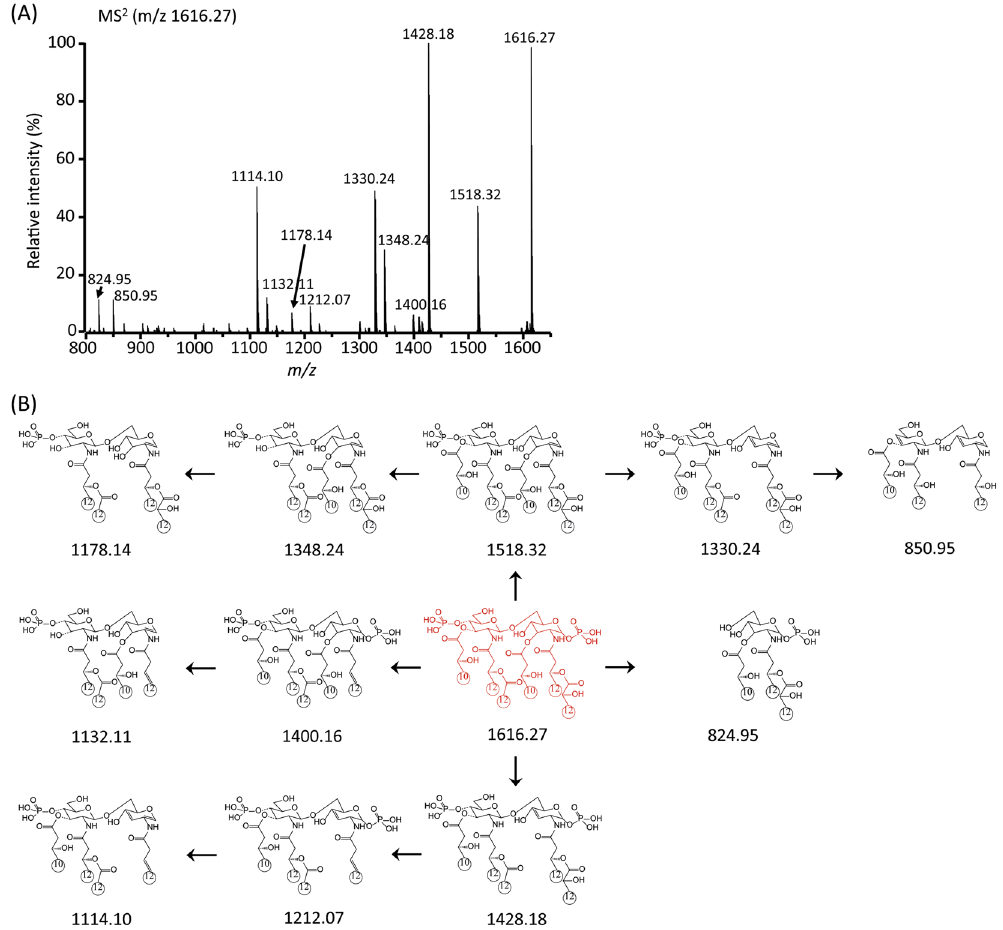
Figure 4. Negative-ion MALDI-QIT-TOF MS 2 spectrum of parent peak at m/z 1616.27 ( A ) and fragment structures corresponding to each fragment ion peak were drawn as neutral molecules ( B